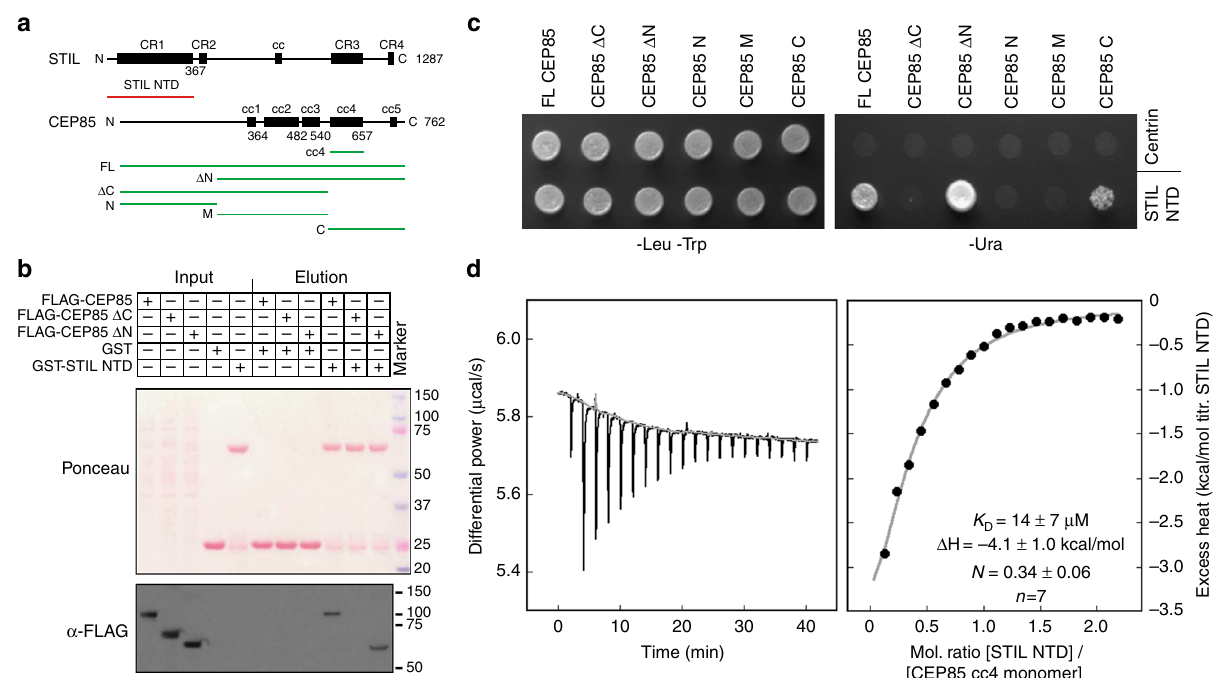
Fig. 4 The N-terminal domain of STIL directly interacts with a C-terminal coiled-coil domain of CEP85. a Domain overview of human STIL and CEP85. CR conserved region; cc coiled-coil; NTD N-terminal domain. Constructs that were used in this work are indicated by red and green lines. b STIL NTD and CEP85 interact. The C-terminal region of CEP85 is required for this interaction. Western blot showing a pull-down experiment with immobilized, recombinant GST or GST-human STIL NTD and lysates from tissue culture cells overexpressing the indicated 3xFLAG-tagged CEP85 constructs. c The C- terminal region of CEP85 shows a yeast-two-hybrid interaction with human STIL NTD. Yeast transformed with the indicated bait and prey constructs were plated on SC-Leu/-Trp plates (selecting for bait and prey plasmid, left) and on SC-Ura plates (selecting for Ura promoter activation, right). d Recombinant chicken STIL NTD and human CEP85 cc4 directly interact with micromolar af fi nity. Typical ITC of chicken STIL NTD and human CEP85 cc4 binding at 25 ° C. The resulting K D , Δ H and STIL NTD/CEP85 cc4 binding stoichiometry ( N ) as an average from a total of seven independent measurements are